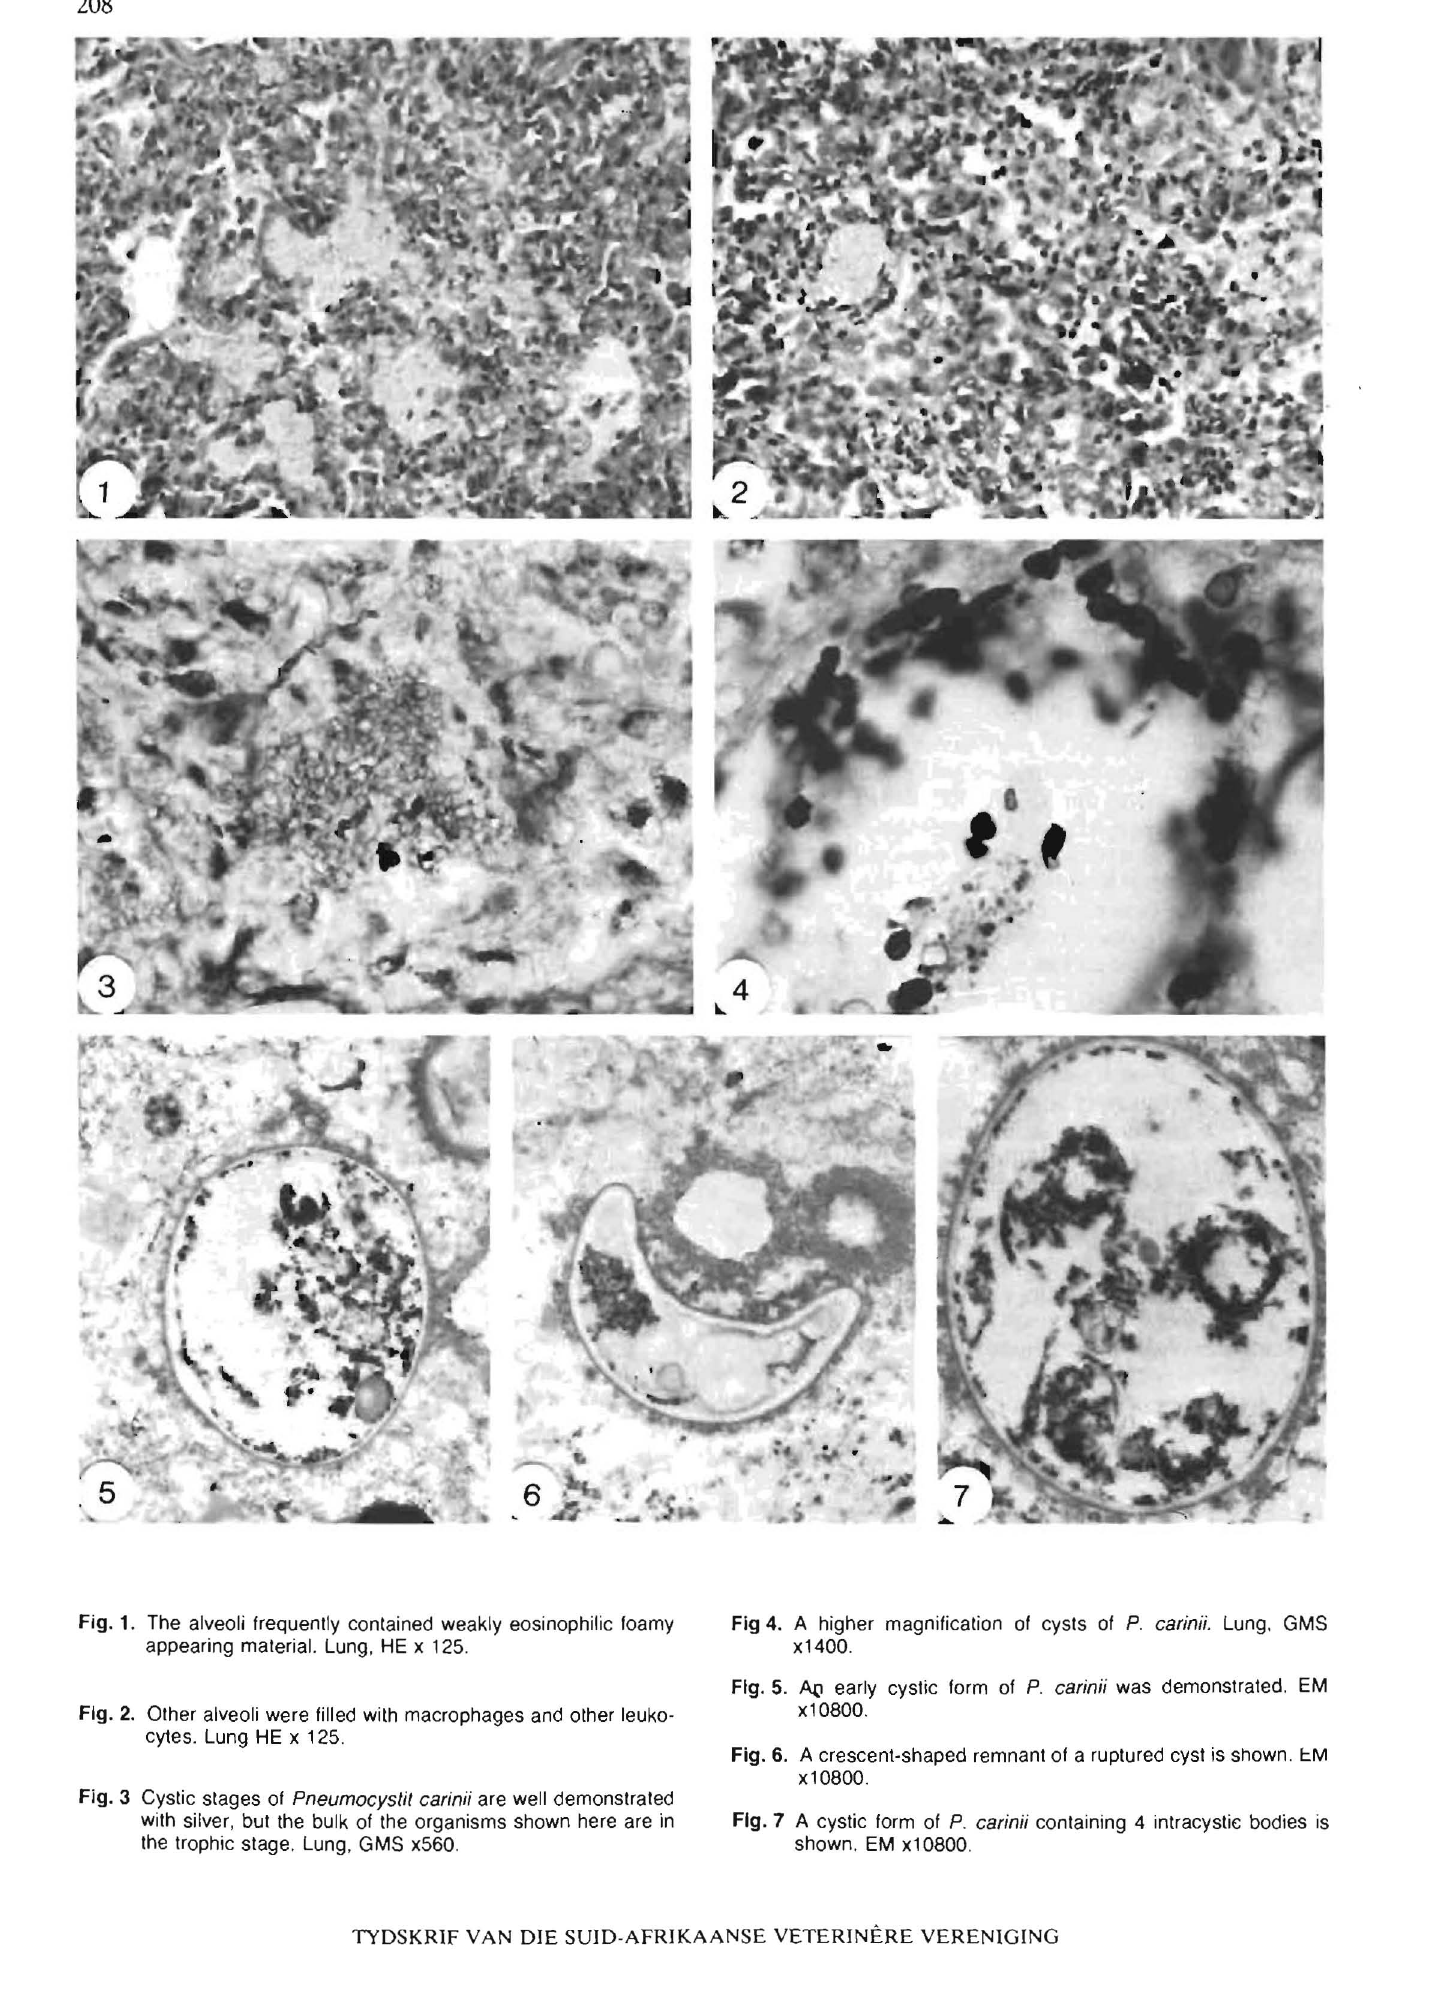
Fig. 1. The alveoli frequently contained weakly eosinophilic foamy appearing material. Lung. HE x 125. Fig. 2. Other alveoli were filled with macrophages and other leuko cytes. Lung HE x 125. Fig. 3 Cystic stages of Pneumocyslit carinii are well demonstrated with silver, but the bulk of the organisms shown here are in the trophic stage. Lung. GMS x560.